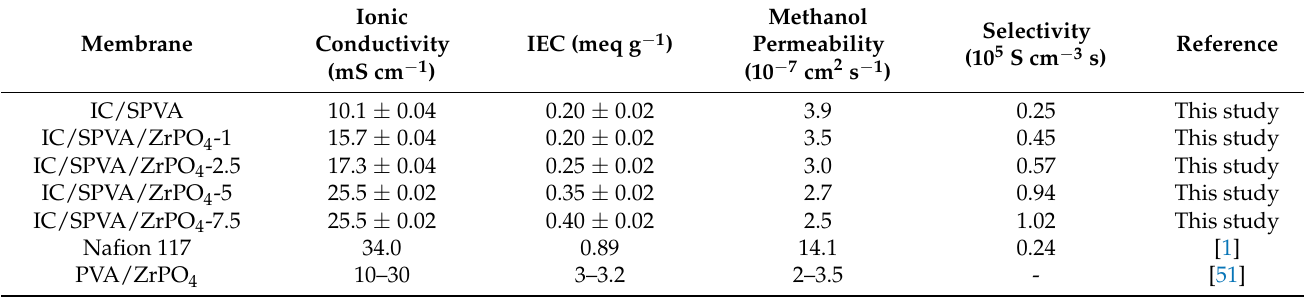
Table 1. Physicochemical properties of the membranes and Nafion [1,31]. Table 2. Methanol permeability, ion exchange capacity (IEC), selectivity, and ionic conductivity of the prepared membranes, previous study, and Nafion